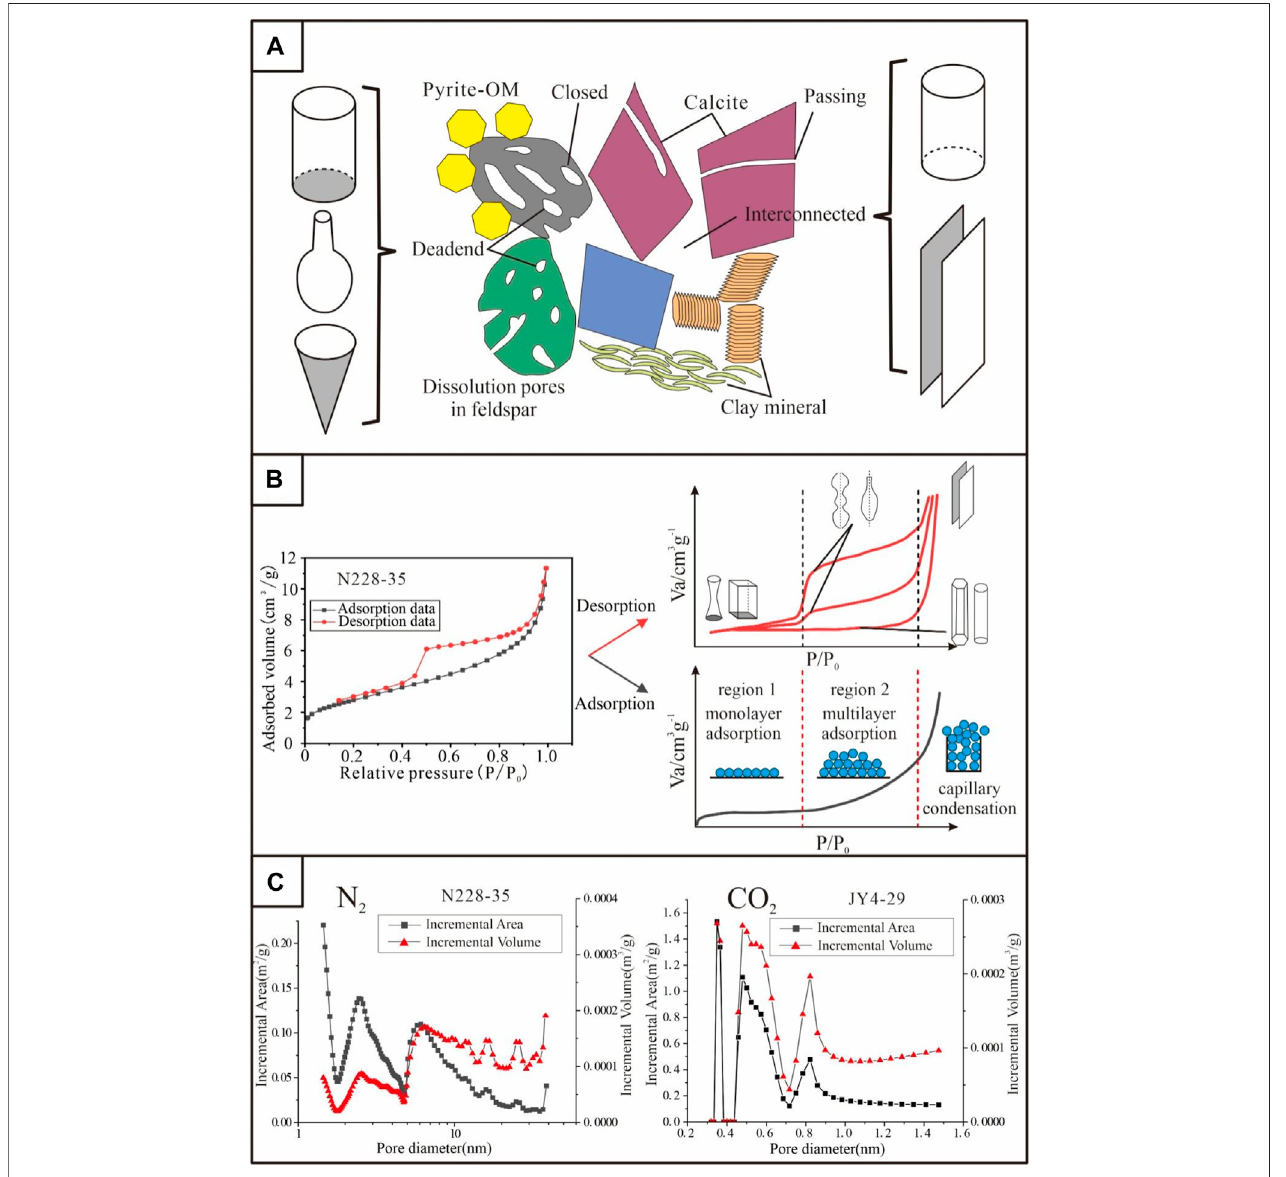
FIGURE8 |(A) Pore morphology ofthe organicmatterand different minerals inshales (modi fi ed from (Nie et al.,2015)); (B) Schematic illustration of gasmolecules inthewholeadsorptionprocessandformationofgas – liquidboundaryfordifferentshapesofpores(modi fi edfrom(Tangetal.,2016;Yinetal.,2019;Nietal.,2020));and (C) Pore-size distribution curves from N 2 adsorption (N228-35, Longmaxi Formation, 3,398.71 m) and CO 2 adsorption (JY4-29, Longmaxi Formation, 2,548.2 m).